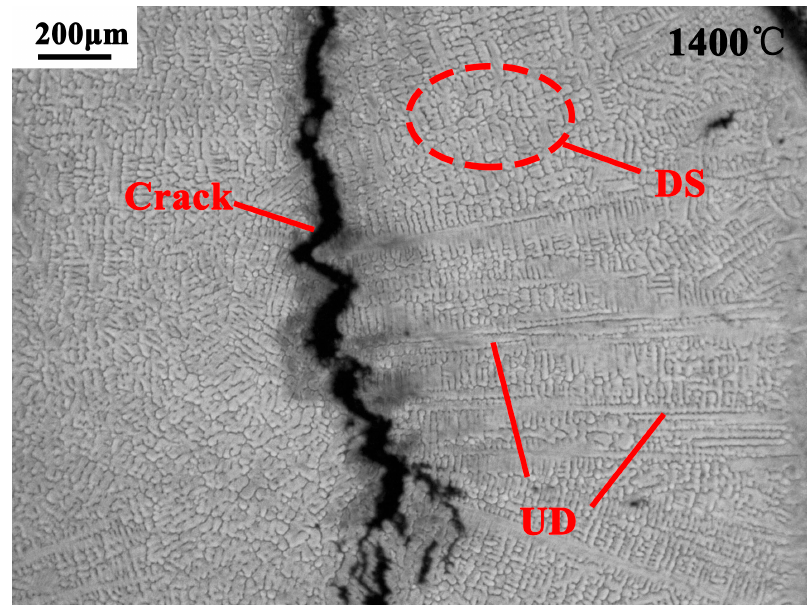
Figure 8. Microstructure of H13 steel deformed at 1400 °C (50%, 0.1/s). UD: Unbroken dendrite. DS: Small dendrite structure.